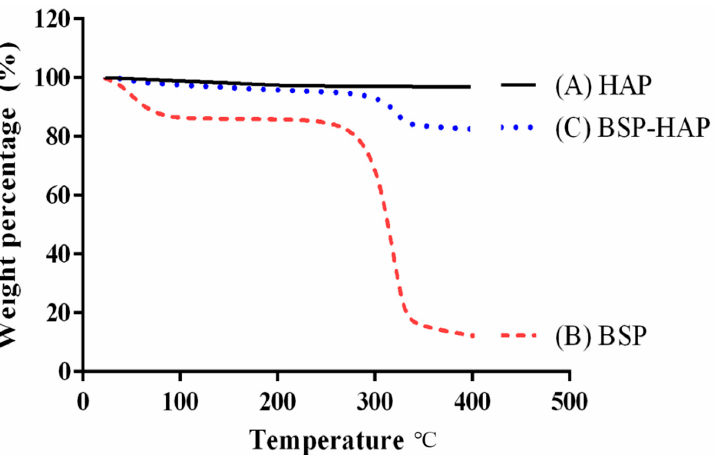
Figure 4. BSP loading efficiency analysis by TGA. The TGA curve of (A) the synthesized HAP,